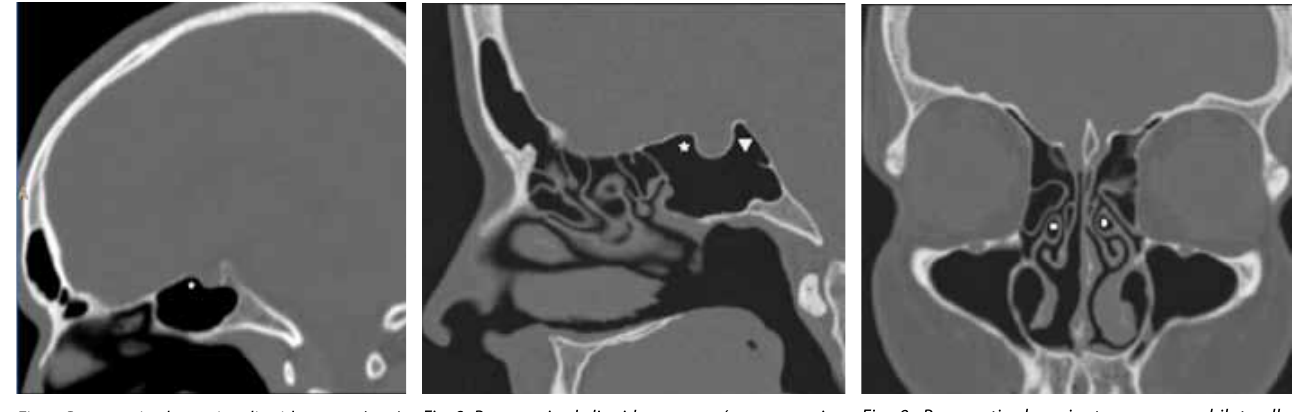
posterior).Fig. 7. Pneumatised anterior clinoid process